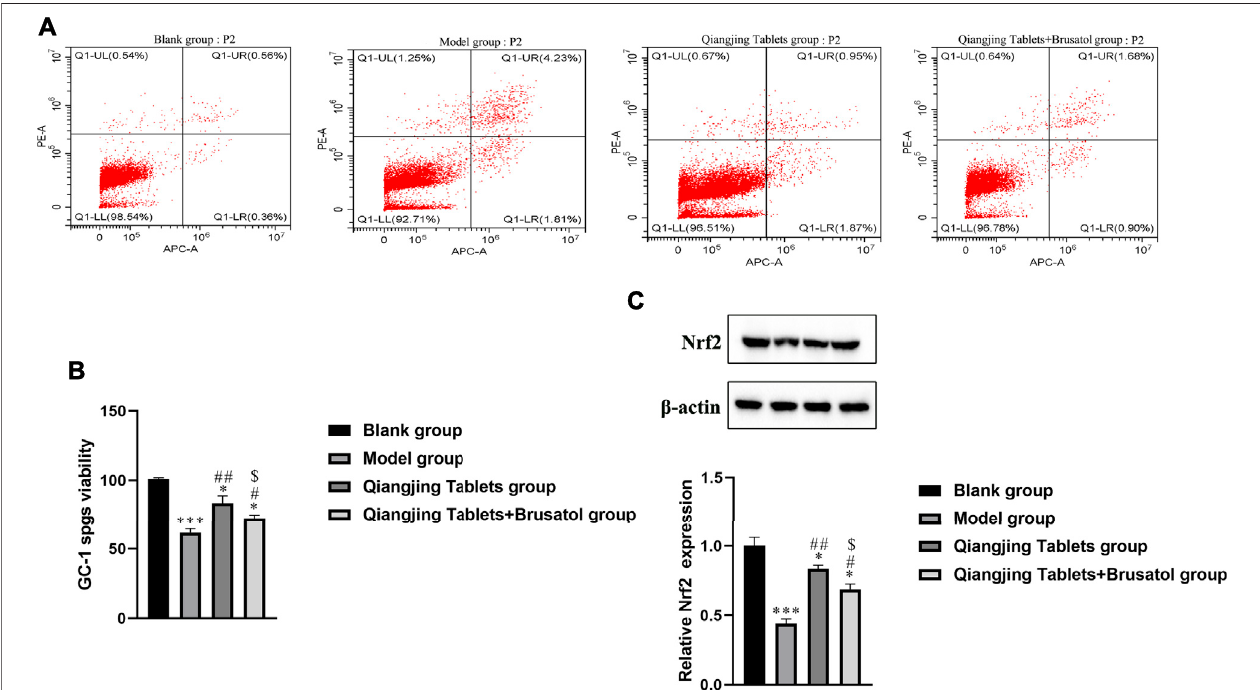
FIGURE 5 | Effect on cell apoptosis of testis and viability of GC-1 spgs . (A) Flow cytometry for Early + Late apoptosis in Blank, model, Qiangjing Tablets and QiangjingTablets+Brusatolgroups. (B) CCK-8assayforassayviability. (C) WesternblottingforNrf2protein.Valuesareexpressedasmean ± SD, n (cid:2) 15pergroup.* p < 0.05 vs . Blank group; *** p < 0.001 vs . Blank group; # p < 0.05 vs . model group; ## p < 0.01 vs . model group; $ p < 0.05 vs . Qiangjing Tablets